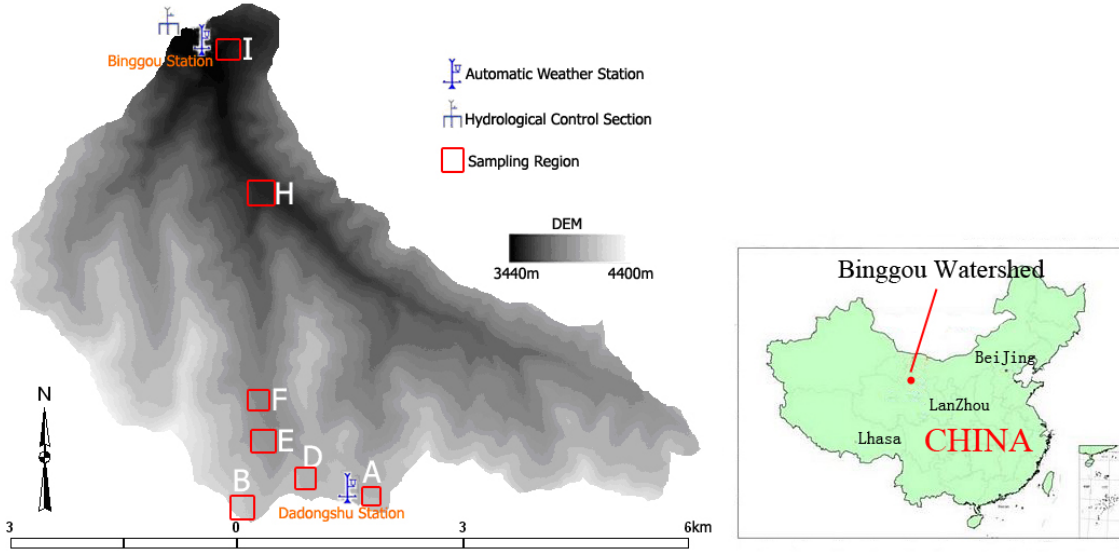
Fig. 1. Map of the Binggou